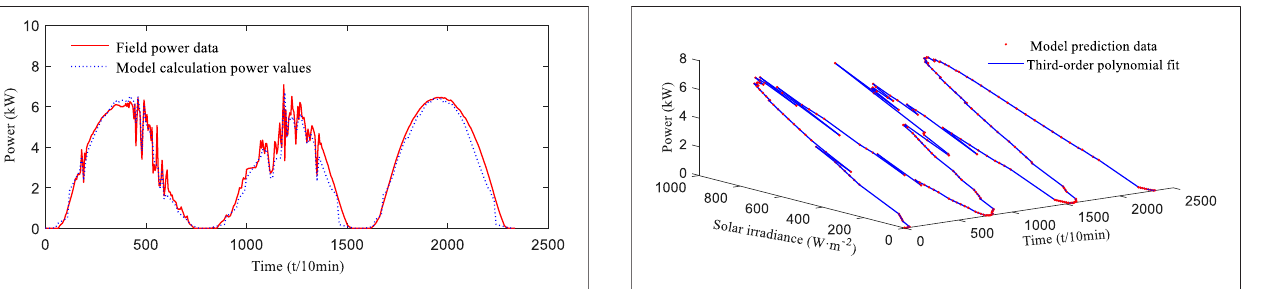
FIGURE 4 | Model calculation power values in forecasting days.